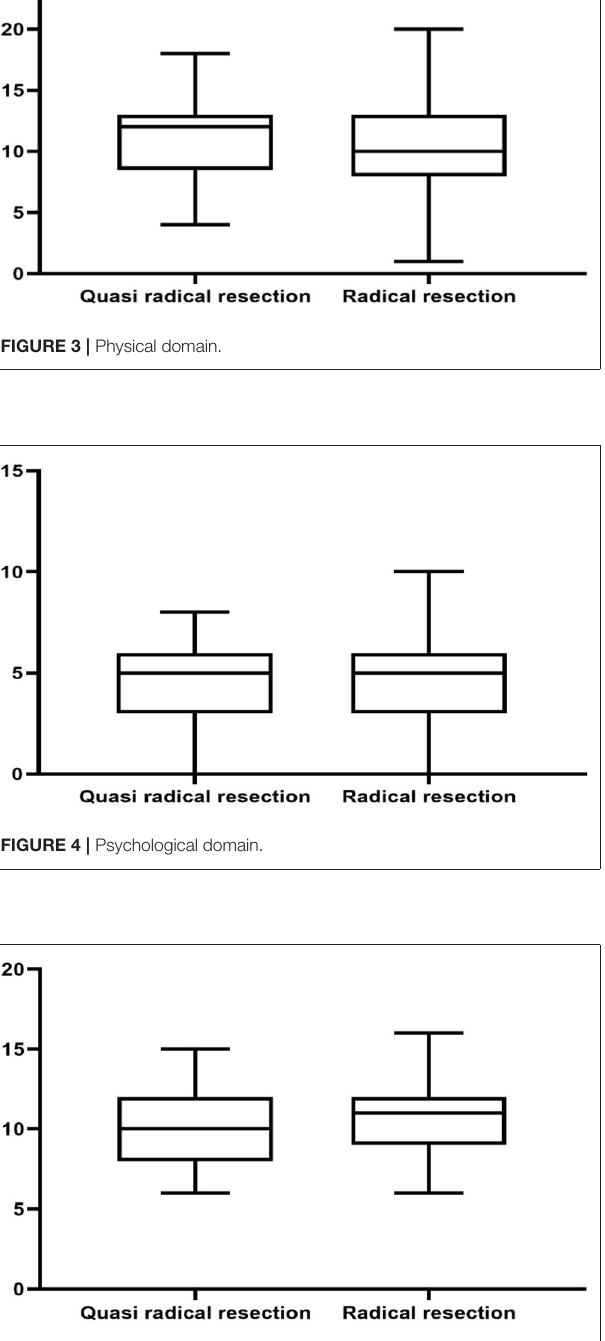
FIGURE 5 | Independent domain.